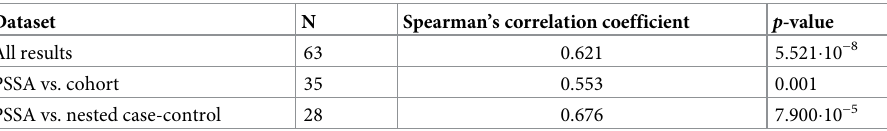
Table 2. Summary of the Spearman-Rank Order Correlation